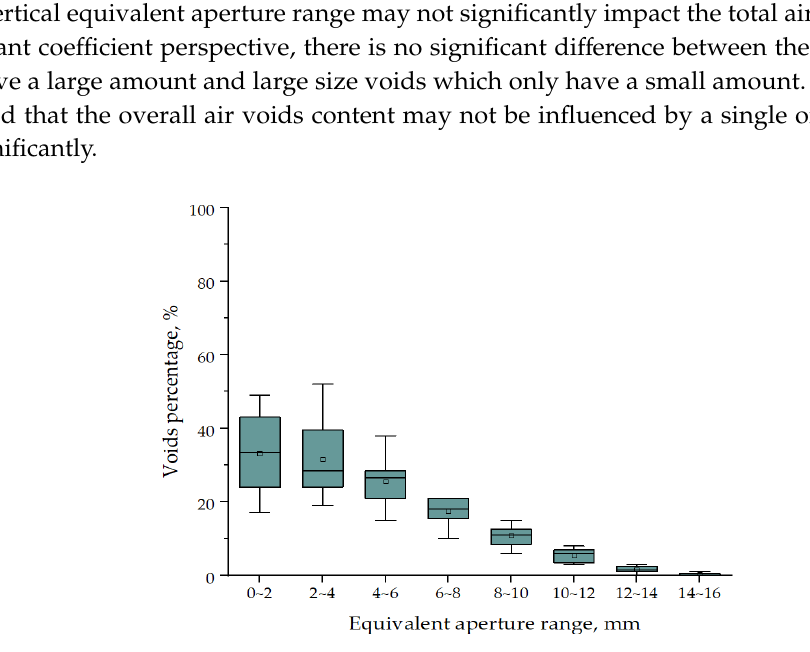
Figure 6. Voids number distribution along the vertical section. Table 1. Coe ffi cient Determinant Matrix.